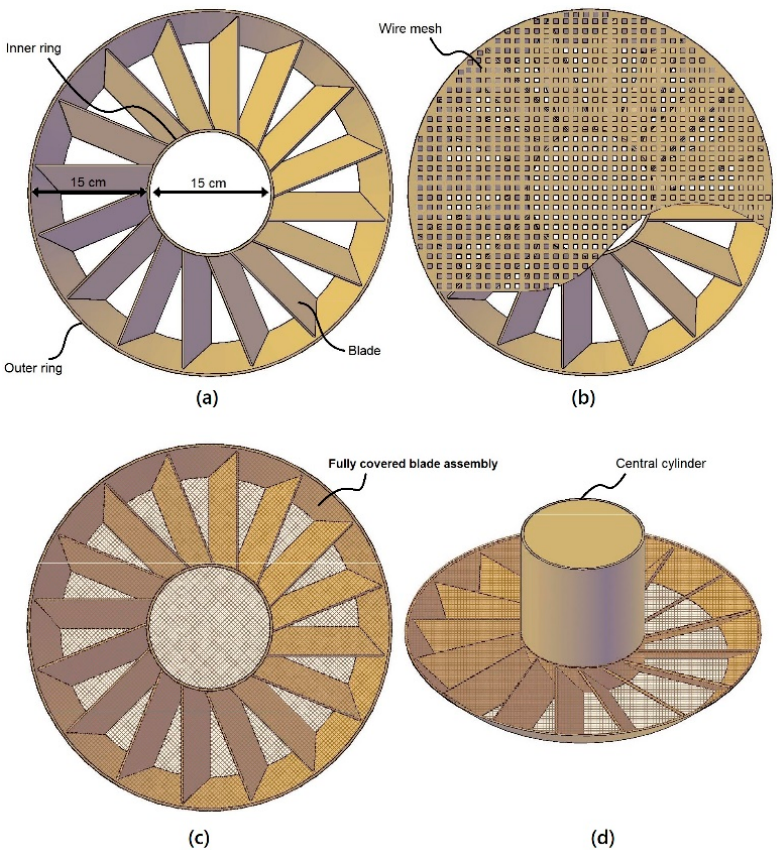
Figure 1. Geometry of mesh-coupled annular distributor: ( a ) fixing of rectangular blades between concentric rings, ( b ) cutaway view of the distributor with mesh cover, ( c ) complete distributor assembly, and ( d ) distributor with solid cylinder in the middle.